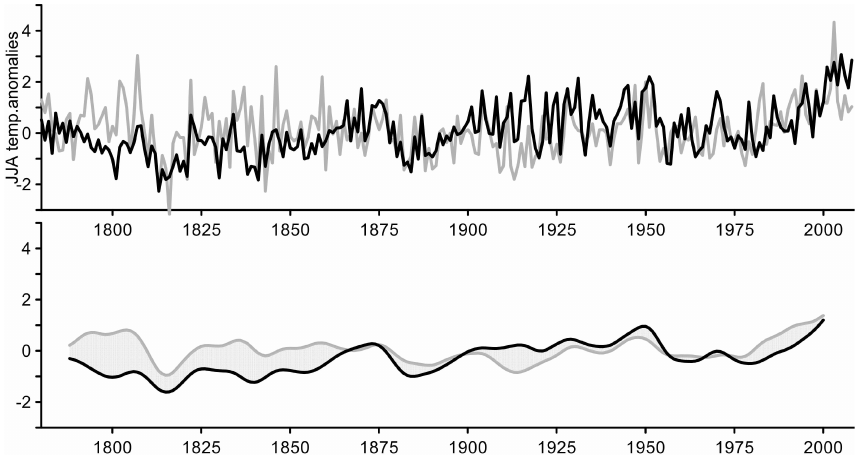
Fig. 5. Comparison of the AdaPres reconstruction of JJA temperatures (black) with the HISTALP JJA mean temperatures (1780–2008, grey) for unfiltered series (top) and after filtering with a 20-yr low-pass filter (bottom).